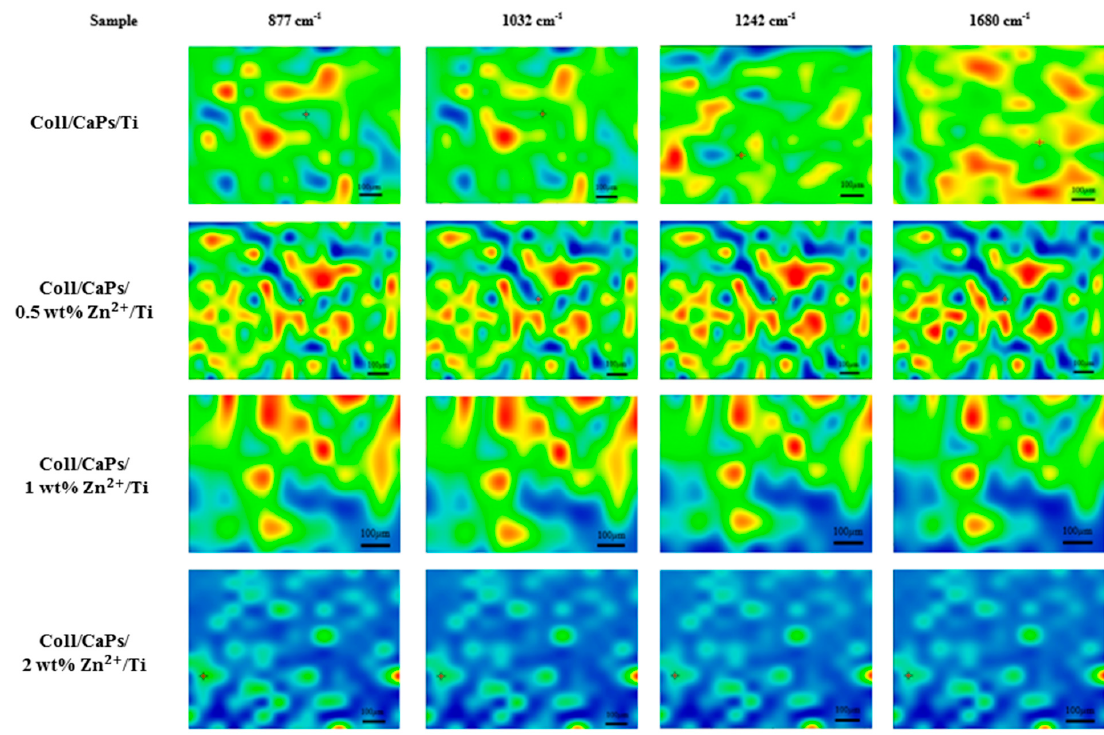
Figure 4. IR mapping of Coll/Zn(II)-CPs thin films deposited on Ti substrate by MAPLE.